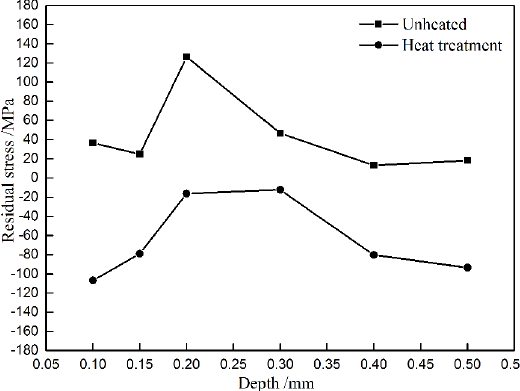
Figure 5. The distribution curve of residual stress in the Z-Y surface in the direction of depth of alloys before and after heat